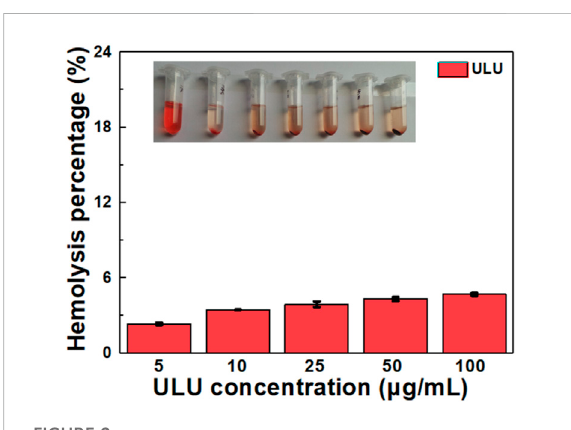
FIGURE 2 Hemolysis rate after 24 h co-culture of ULU nanoliposomes with